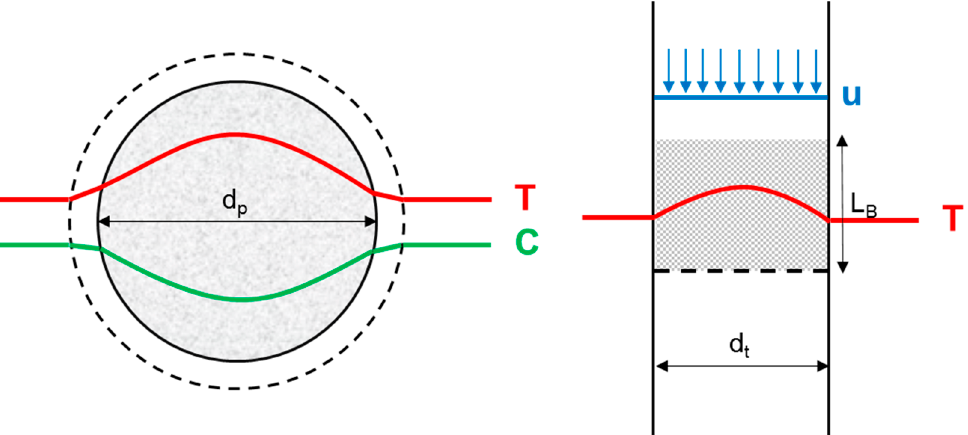
Figure 3. Possible exothermal temperature and reagent concentration gradients in a packed-bed tubular reactor under plug-flow conditions on the pellet scale ( left ) and reactor scale ( right ).